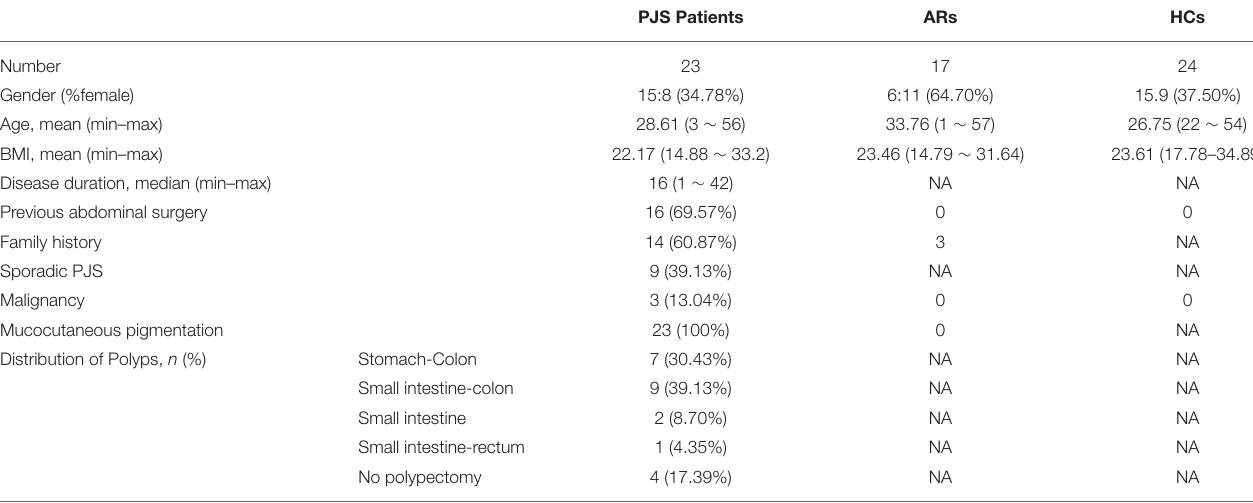
TABLE 1 | Demographic and clinical data of patients with Peutz–Jeghers syndrome (PJS), asymptomatic relatives (ARs), and healthy controls (HCs).